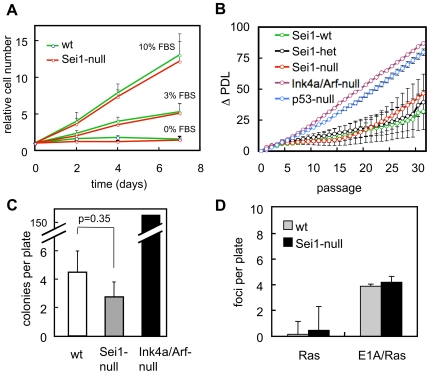
Proliferation, immortalization and transformation of Sei1-null MEFs.
(A) Growth curves of primary MEFs grown at the indicated serum concentrations. (B) Senescence and immortalization were evaluated performing a 3T3 serial passage protocol of MEFs of the indicated genotype. ΔPDL, increase in population doubling level (C) Colony formation assay measuring the immortalization potential of MEFs of the indicated genotypes. (D) Foci formation assay of MEFs transduced with HRasV12 or with bicistronic E1A/HRasV12. In all the above assays, at least three independent preparations of primary MEFs per genotype were used. Values correspond to average and s.d.